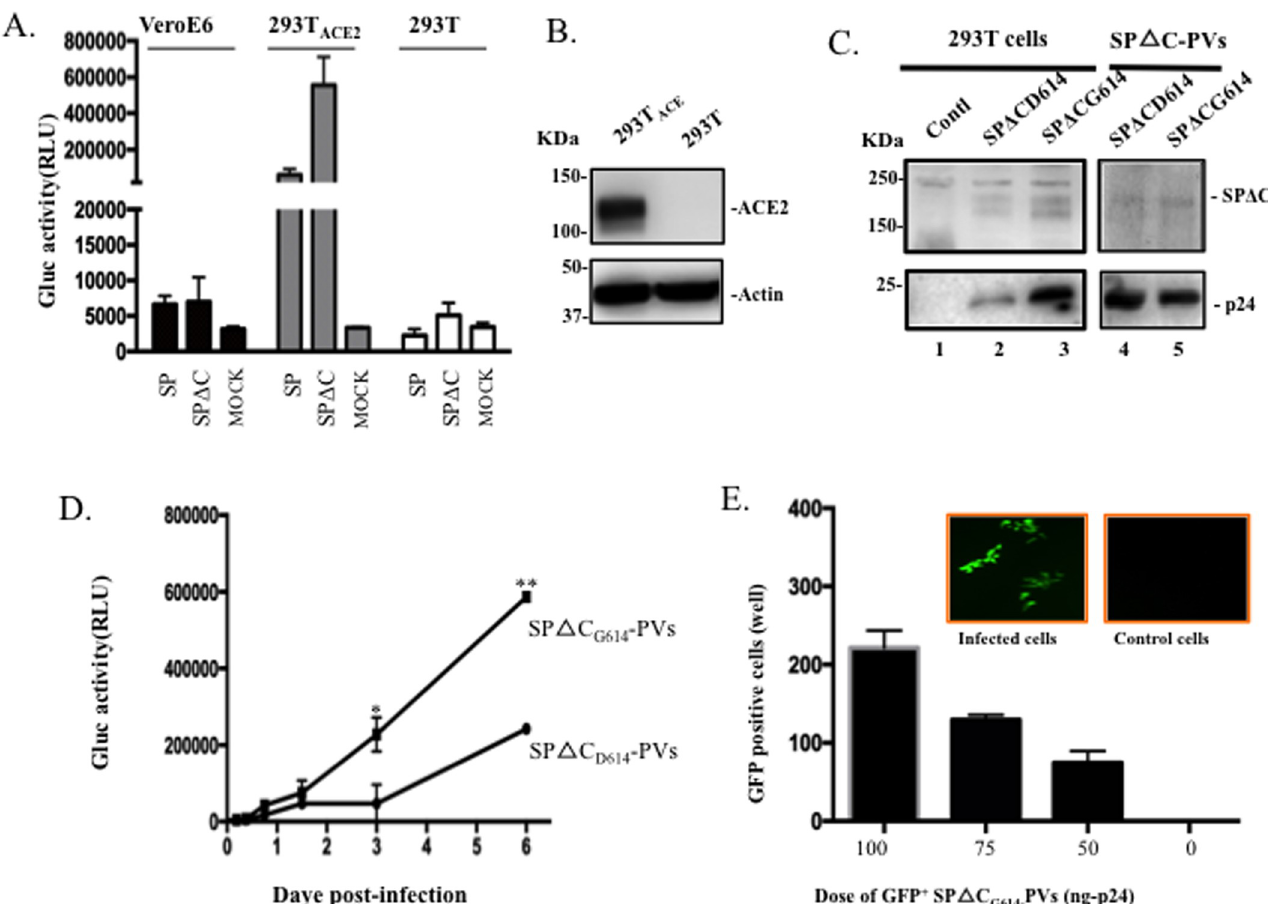
Fig 2. SARS-CoV-2 SP-PVs’s infection in different cell lines and SARS-CoV-2 SP G416 variant exhibited stronger virus entry. A) 293T ACE2, 293T, and Vero- E6 cells were infected by equal amounts of SARS-CoV-2SP- or SARS-CoV-2SP Δ C-pseudotyped viruses (PVs), or mock-infected (MOCK). At 48 hrs pi, the Gluc activity in supernatants was measured. B) The expression of SARS-CoV-2SP receptor, ACE2 in 293T and 293T ACE2 cells detected by WB with anti-ACE2 antibodies. C) Detection of SARS-CoV-2 SP Δ C, SP Δ C G614 and HIV p24 protein expressions in transfected 293T cells and viral particles by WB with corresponding antibodies. D) Infectivity comparison of SP Δ C D614 -PVs and SP Δ C G614 -PVs in 293T ACE2 cells. Equal amounts of SP Δ C D614 -PVs and SP Δ C G614 - PVs virions (adjusted by p24 level) were used to infect 293T ACE2 cells. At different days post-infection (pi), Gluc activity in supernatants was measured. The results are the mean ± SD of duplicate samples, and the data are representative of results obtained in two independent experiments. E) The SP Δ C G614 -GFP + PVs were produced from 293T cells and used to infect 293T ACE2 cells in 96-well plate After 48 hrs pi, GFP-positive cells (per well) were counted and photographed by fluorescence microscope (on the top of the panel). Statistical significance was determined using unpaired t-test, and significant p values are represented with asterisks, � � 0.05, �� � 0.01.